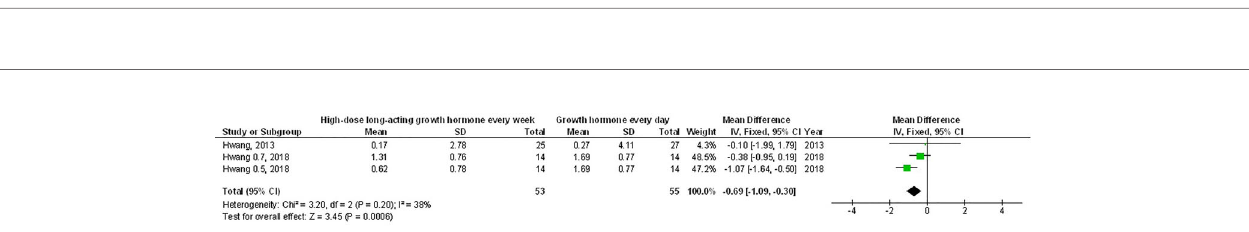
FIGURE 5 | Forest plot of the change in insulin-like growth factor 1 standard deviation scores in long-acting growth hormone replacement therapy compared to daily growth hormone.